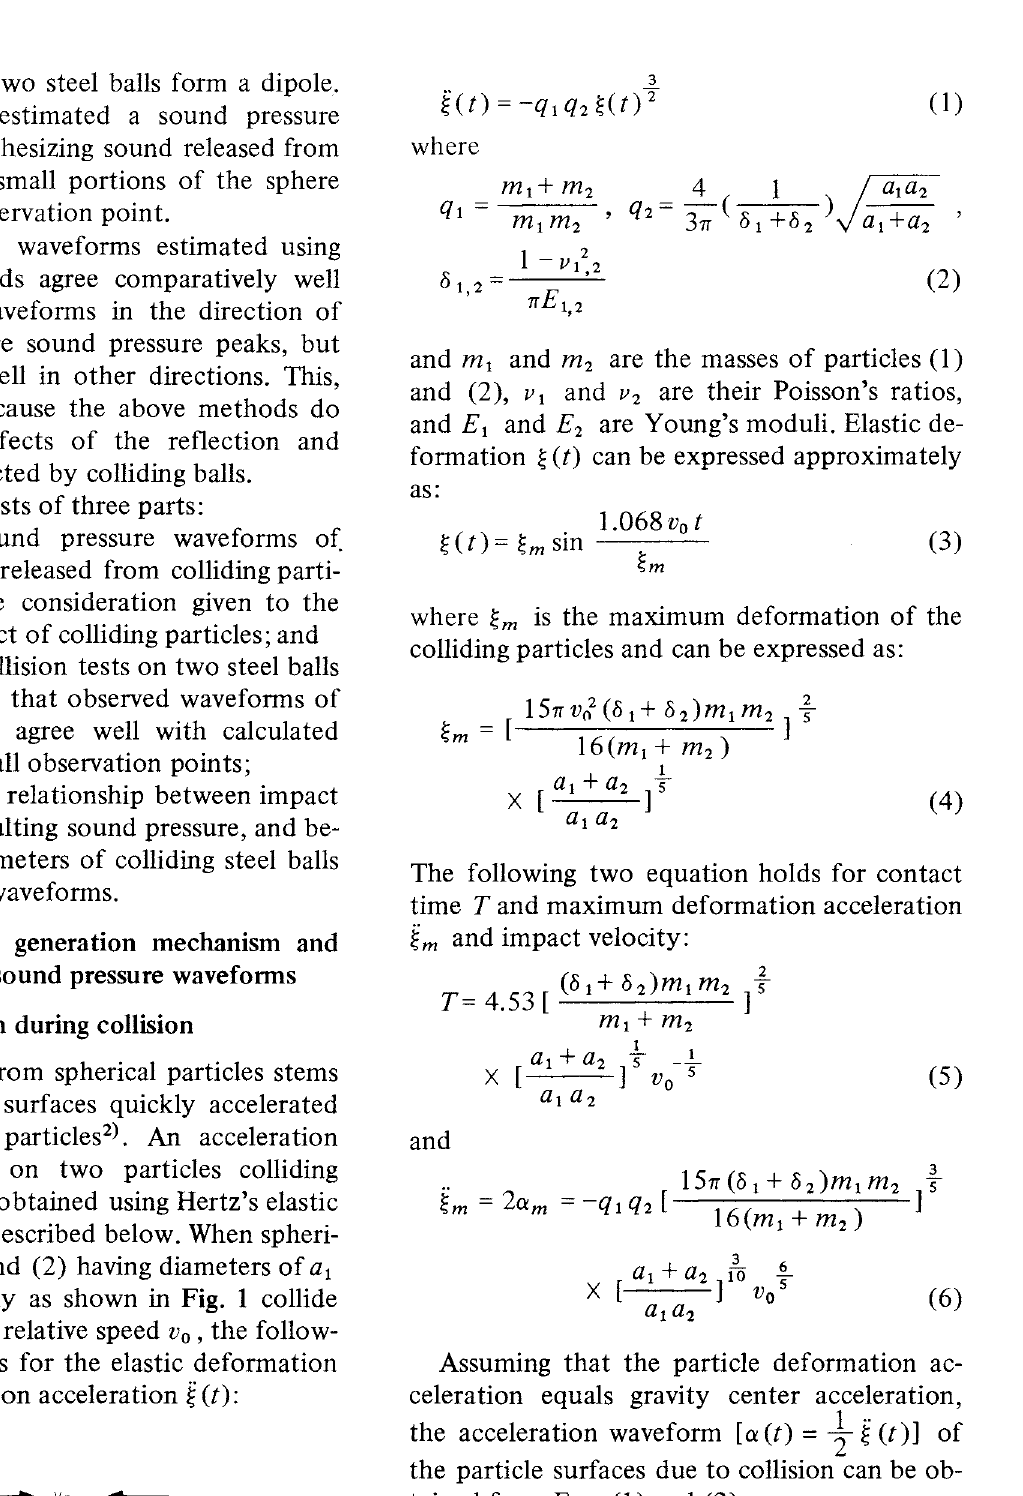
Fig. 1 Collision between two elastic particles